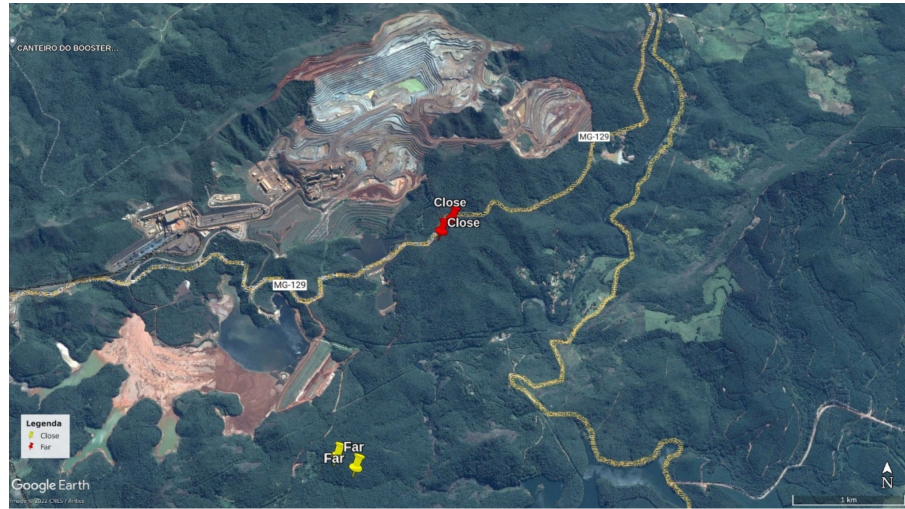
Figure 1. Position of the two acoustic sensors within the study areas (one near and one far from the Brucutu Mine), both within the Peti reserve, Minas Gerais,